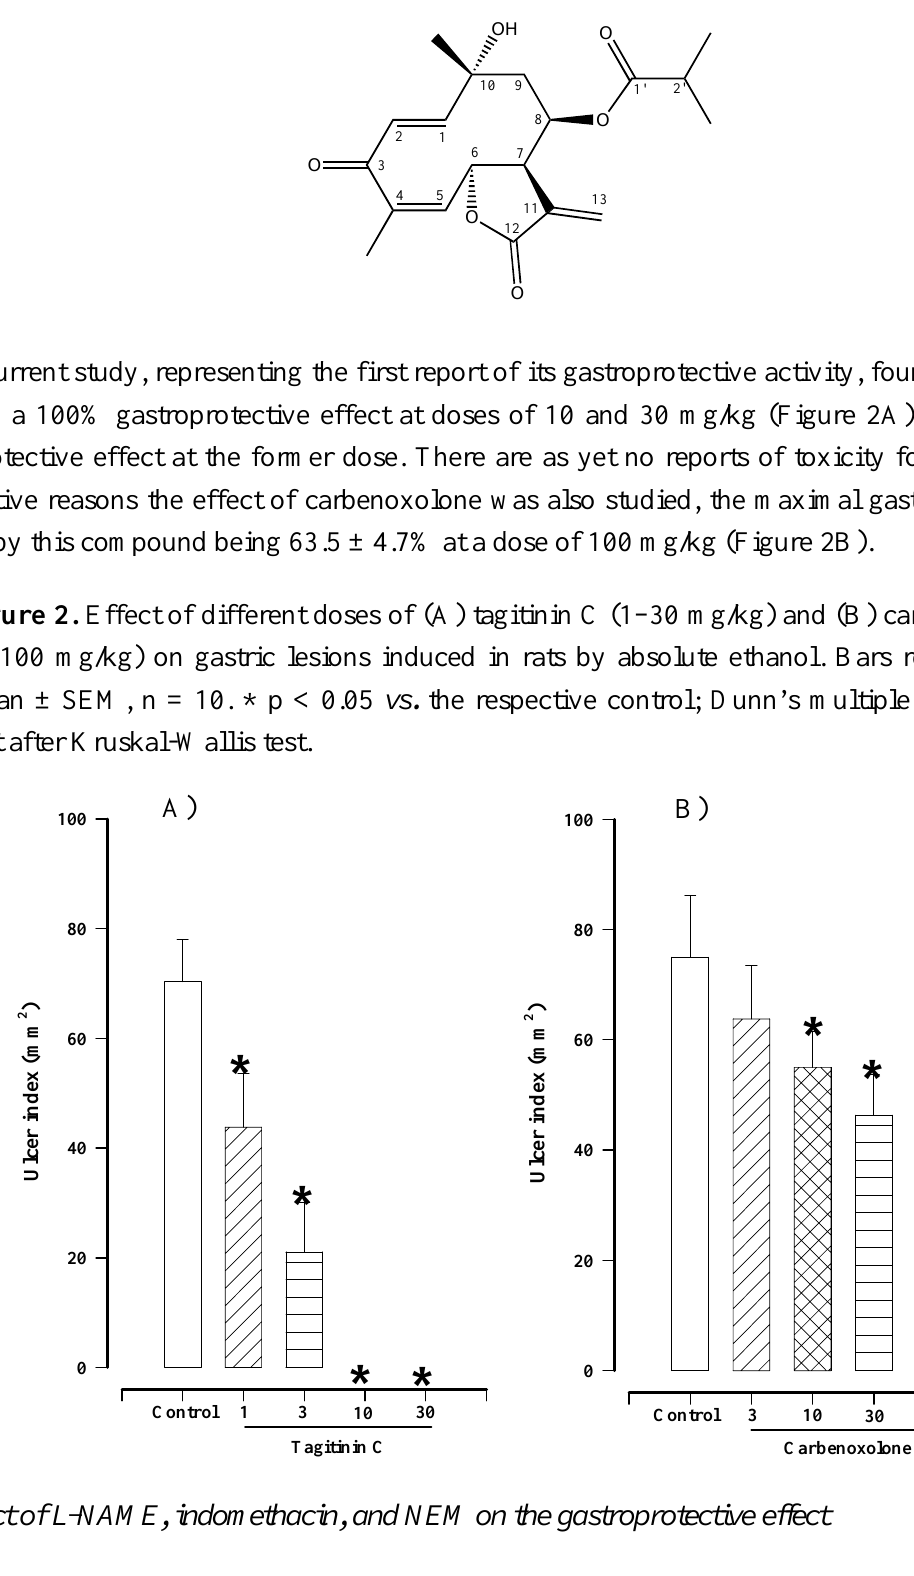
Figure 1. The structure of tagitinin